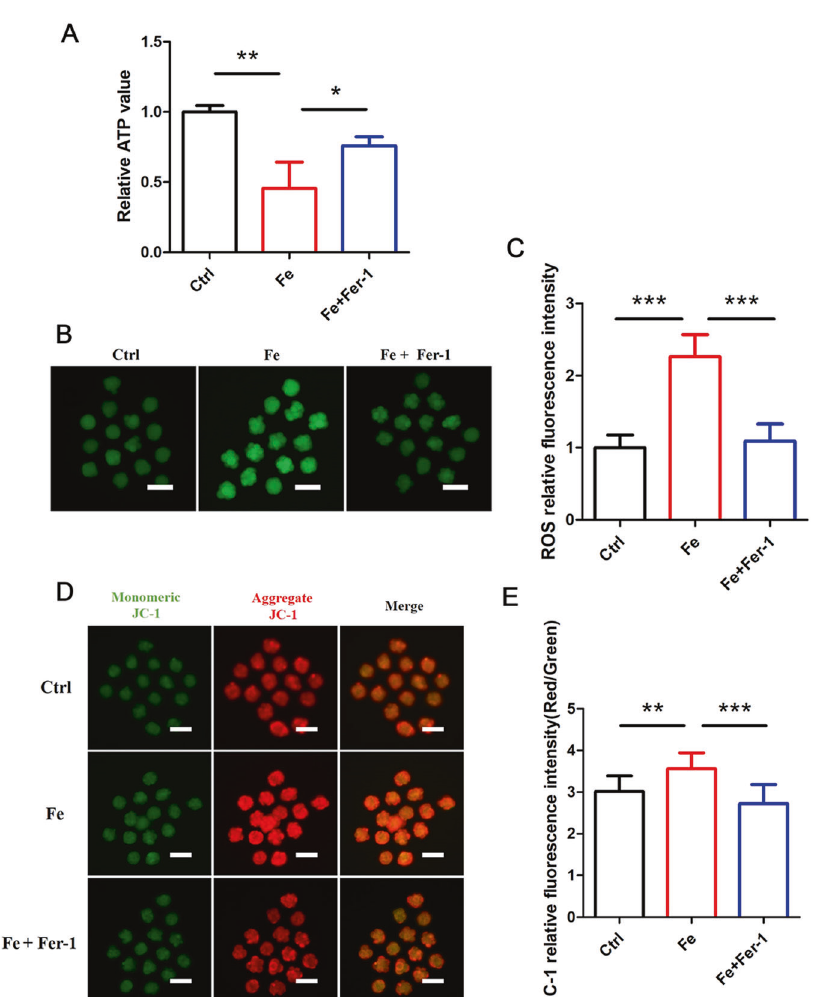
Fig. 4 Iron overload caused mitochondrial damage in mouse embryo. A ATP of mouse embryos cultured with Fe and Fe + Fer-1 were measured using a bioluminescent assay system. Data are represented as mean ± SD. * P < 0.05, ** P < 0.01. B Reactive oxygen species (ROS) detection of mouse embryos cultured with Fe and Fe + Fer-1, the scale bar = 100 μ m. C Relative fl uorescence intensity statistics of ROS in control ( n = 15), Fe ( n = 14) and Fe + Fer-1 ( n = 15). Data are expressed as mean ± SD. *** P < 0.001. D MMP detection of mouse embryos cultured with Fe and Fe + Fer-1 by using JC-1 staining. When excited at 488/561 nm, JC-1 monomers emit a green fl uorescence with a maximum at ~510 nm, and high MMP aggregate JC-1 emits red fl uorescence with a maximum at ~590 nm. The scale bar = 100 μ m. E Relative fl uorescence intensity statistics of JC-1 (Red/Green) in the control ( n = 15), Fe ( n = 15) and Fe + Fer-1 ( n = 15). Data are expressed as mean ± SD. ** P < 0.01, *** P < 0.001. Quantitation of ATP production Detection of the mitochondrial membrane potential The relative ATP level was measured using the ENLITEN ® ATP Assay System The mitochondrial membrane potential (MMP) in embryos was measured Bioluminescence Detection Kit (Promega, USA) according to the manu- by staining with 5,6,6-dichloro-1,1,3,3-tetraethyl-imidacarbocyanine iodide facturer ’ s instructions. Embryos with or without treatment were lysed in (JC-1) according to the manufacturer ’ s instructions (Beyotime, China). The cell lysis buffer. The ATP content of the embryo was then detected in a 96- embryos were incubated in MOPS medium containing 1 μ M JC-1 for 15min well white opaque plate containing luciferase, luciferin, and buffer by at 37 °C in the dark. After incubation, the embryos were washed twice with bioluminescence on a multimode microplate reader (TECAN, Swit). PBS and observed under an epi fl uorescence microscope (Nikon ECLIPSE Ti,